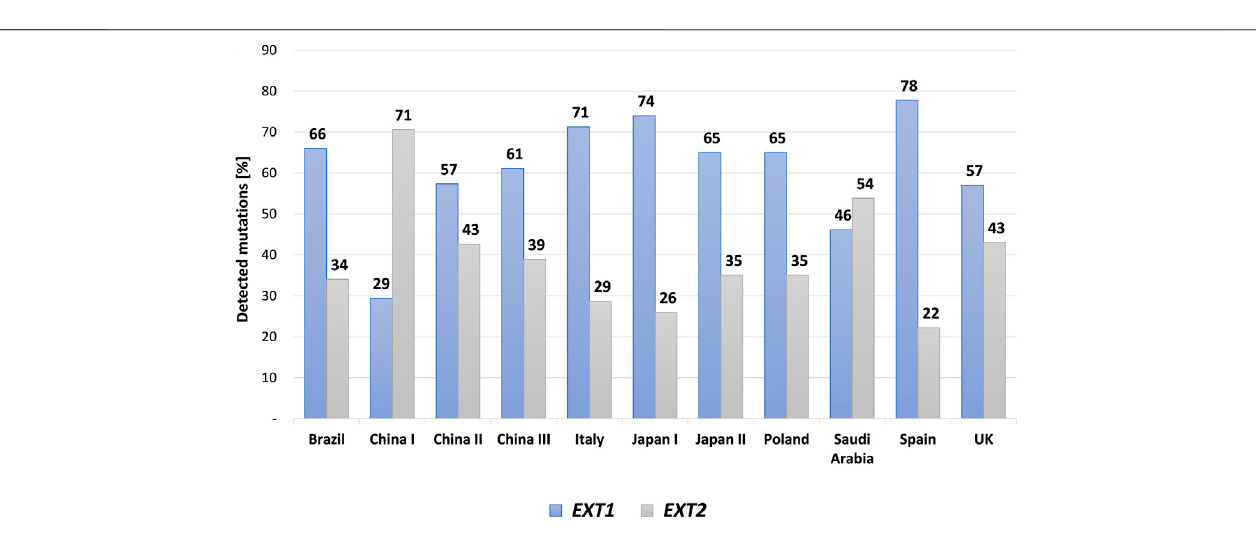
Frontiers in Genetics |